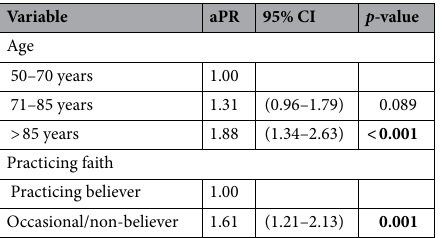
Table 4. Multivariable analysis of socio demographic and patient characteristics associated with probable dementia. Significant values are in bold.